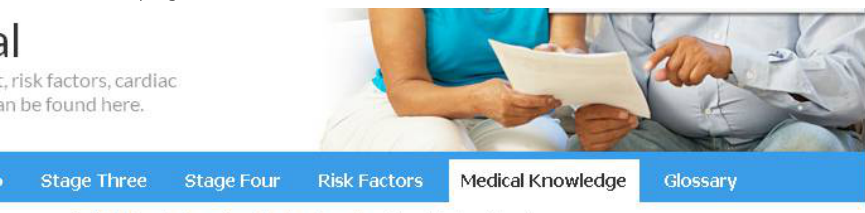
Figure 2. Information about heart disease contained in the